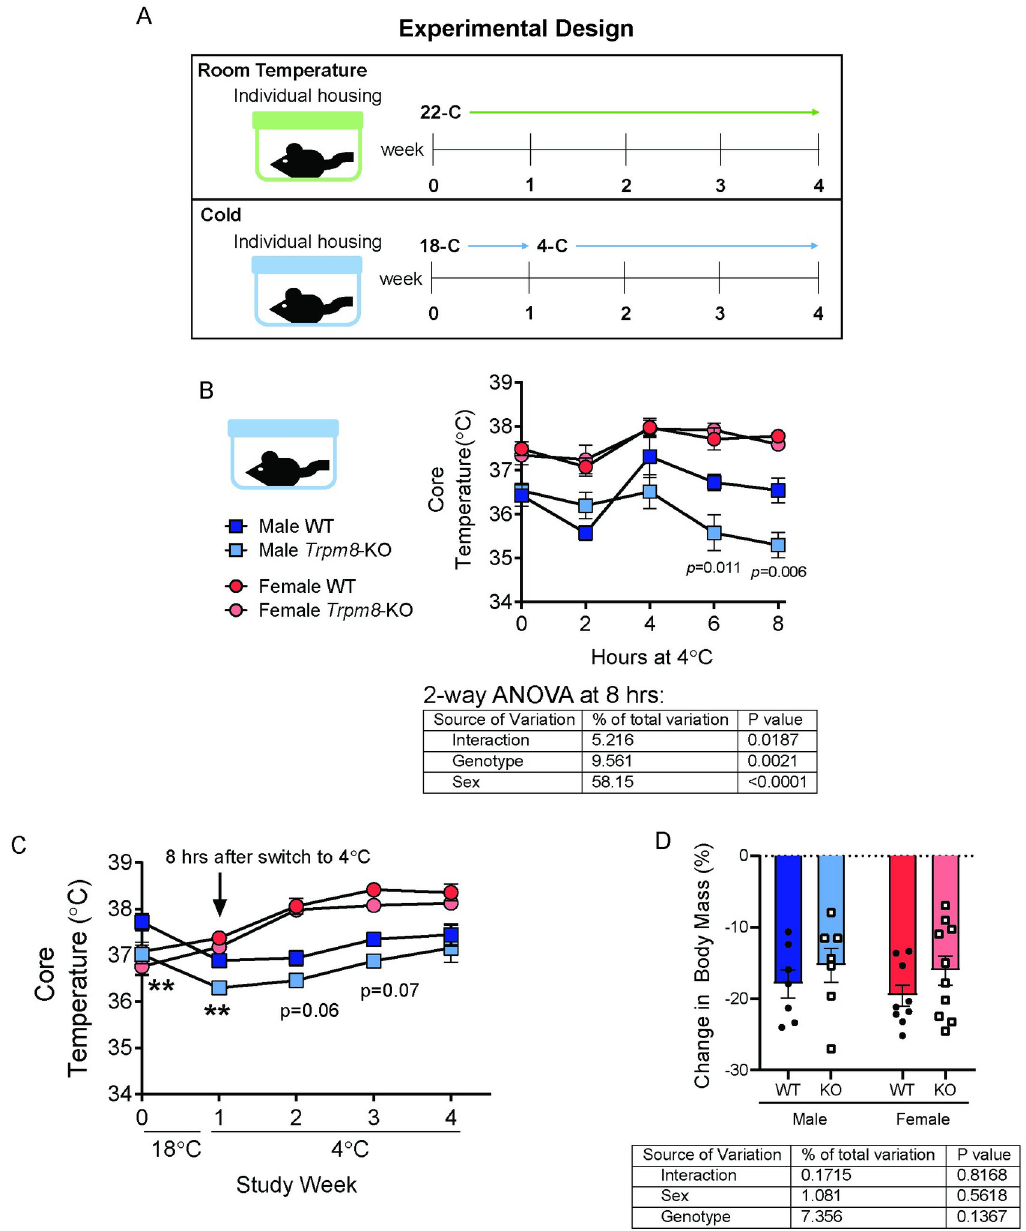
Fig 4. Male Trpm8-KO mice had lower core temperature during acclimatization to cold. (A) At 52 weeks of age, mice were separated into individual cages and half were kept at room temperature while the other half were moved to a cold room set at 18˚C. After one week, the temperature was changed to 4˚C and mice were maintained for 3 additional weeks. (B) During the temperature change from 18˚C to 4˚C, core temperature was measured every 2 hours. (C) Weekly core temperature, starting from time zero before mice were moved into the cold, and including the data from the 8 hour time point of the day the temperature changed from 18˚C to 4˚C. (D) Percent change in body weight. N = 7-11/group. Temperature data points represent mean ± SEM. Body weight data are expressed as individual points with bars representing mean ± SEM. Table below panels B and D indicate results of the two-way ANOVA (performed using data from 8 hr time point in B), with p- values for sex, genotype and their